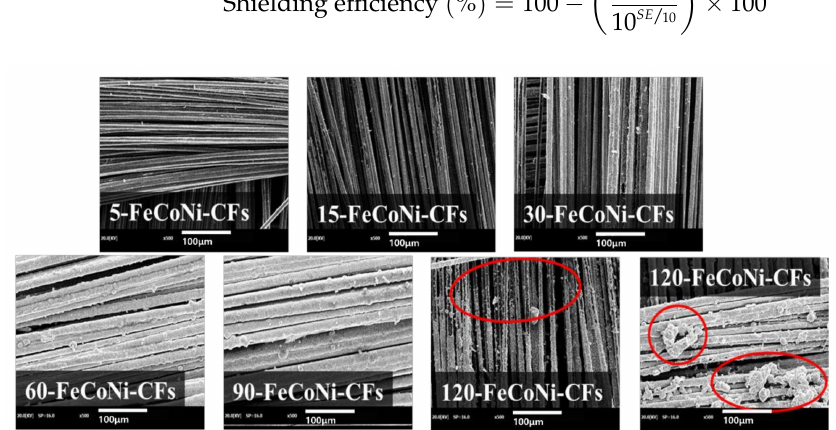
Figure 7. SEM images of FeCoNi-CFs as a function of plating